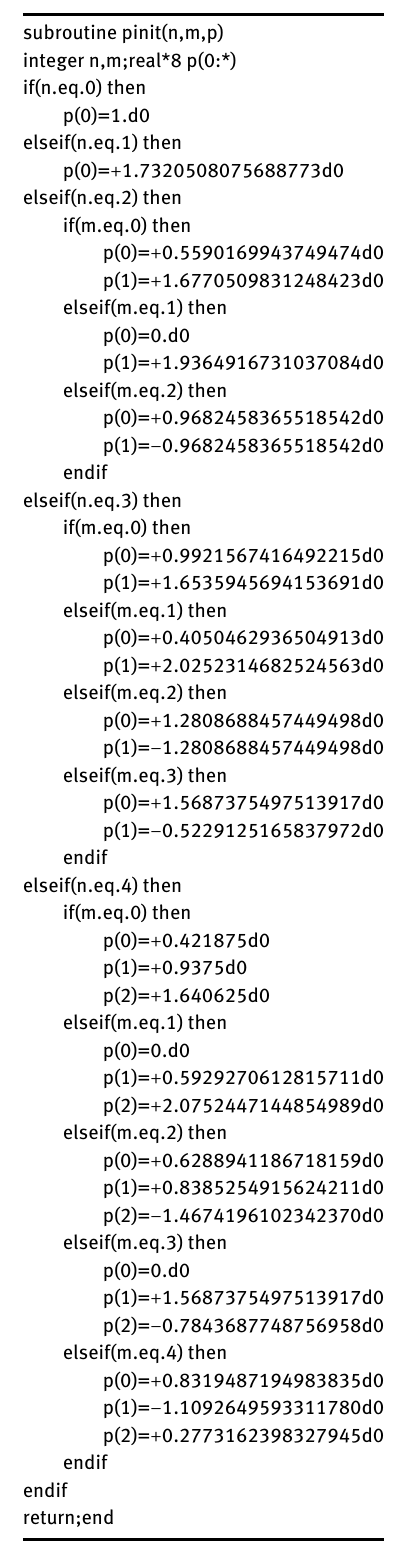
Table 3: Fortran subroutine to return P nmj when n ≤ 4 . It returns p ( j ) = P nmj as a vector with respect to j . This is a straightforward implementation using Table